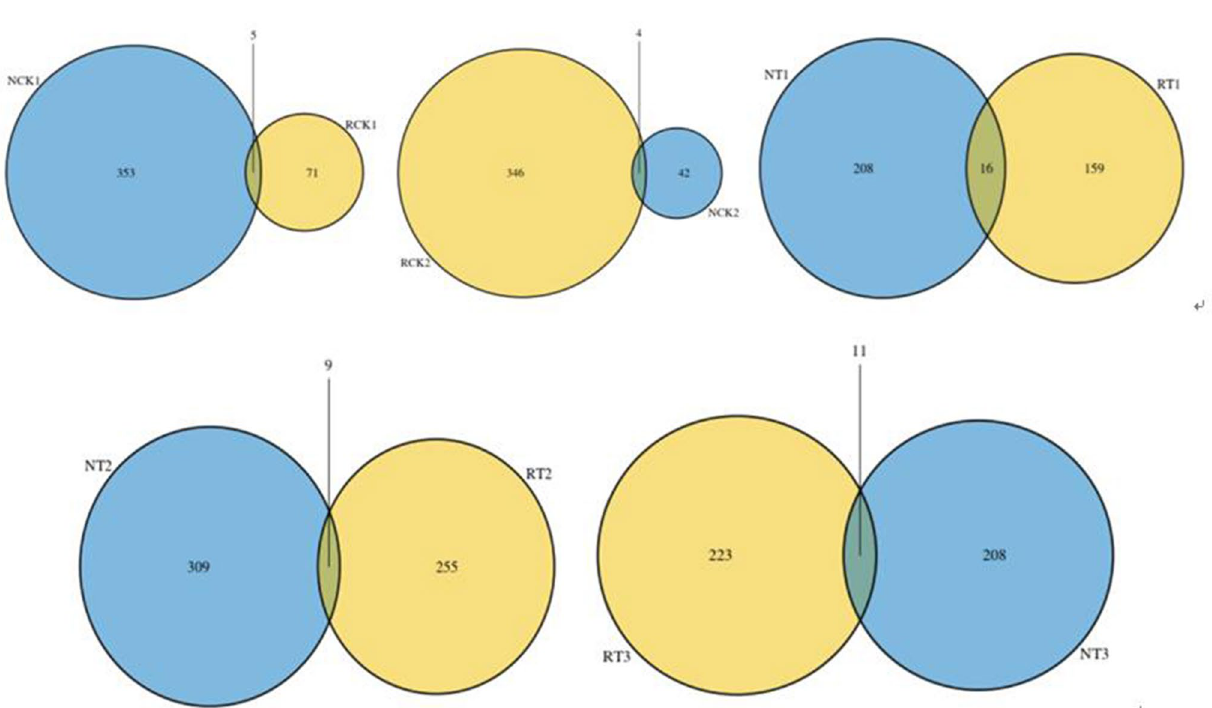
Figure 2. Venn diagrams showing the distribution of OTUs between the rhizosphere soil and bulk soil of different treatments. RCK1: R-soil in CK1; RCK2: R-soil in CK2; RT1: R-soil in T1; RT2: R-soil in T2; RT3: R-soil in T3; NCK1: N-soil in CK1; NCK2: N-soil in CK2; NT1: N-soil in T1; NT2: N-soil in T2; NT3: N-soil in